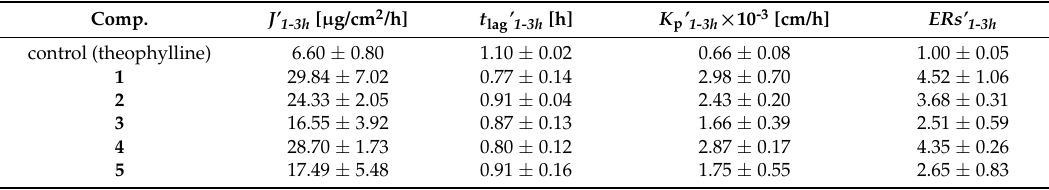
Table 3. Pseudo-permeation parameters of theophylline in range 1–3 h without (control) and with tested CPEs 1 – 5 from propylene glycol:water (1:1): steady-state permeation fluxes ( J’ ), corresponding lag times ( t lag ’ ), permeability coefficients ( K p (cid:48) ), and enhancement ratios ( ERs’ ). All values are expressed as mean ± SD ( n = 5